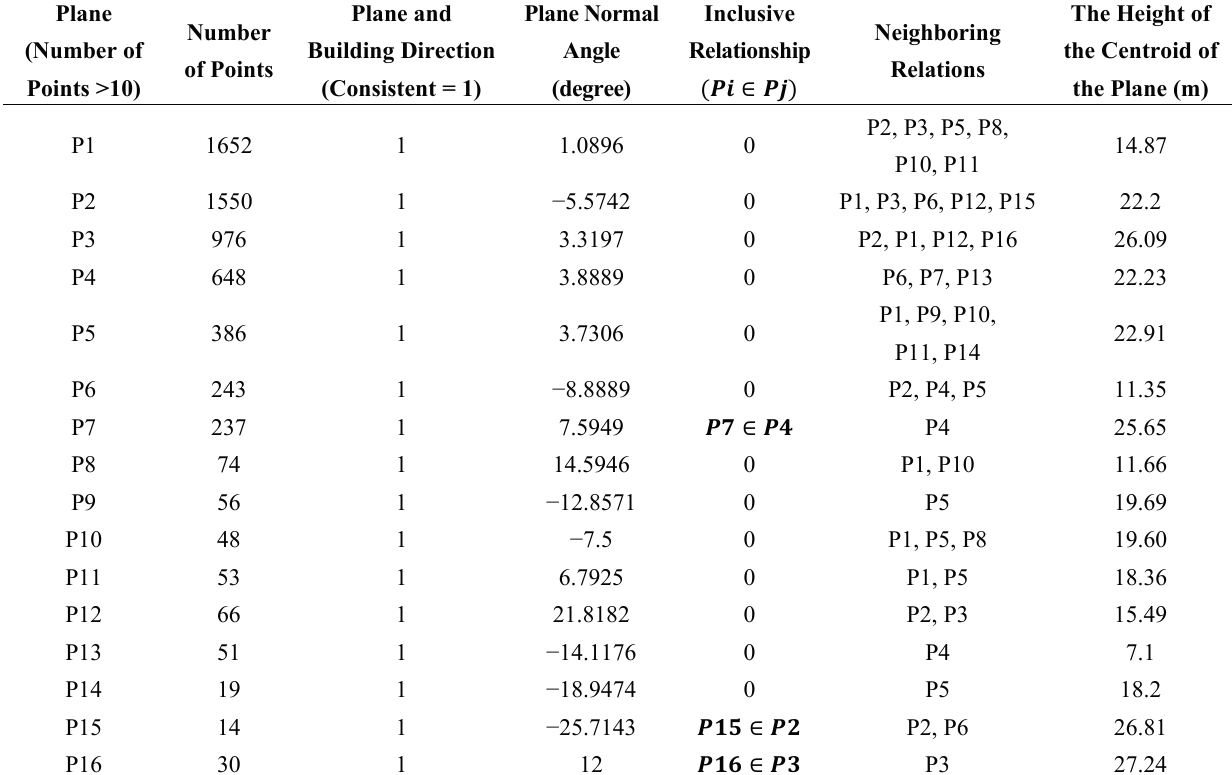
Table 1. Data structure of building